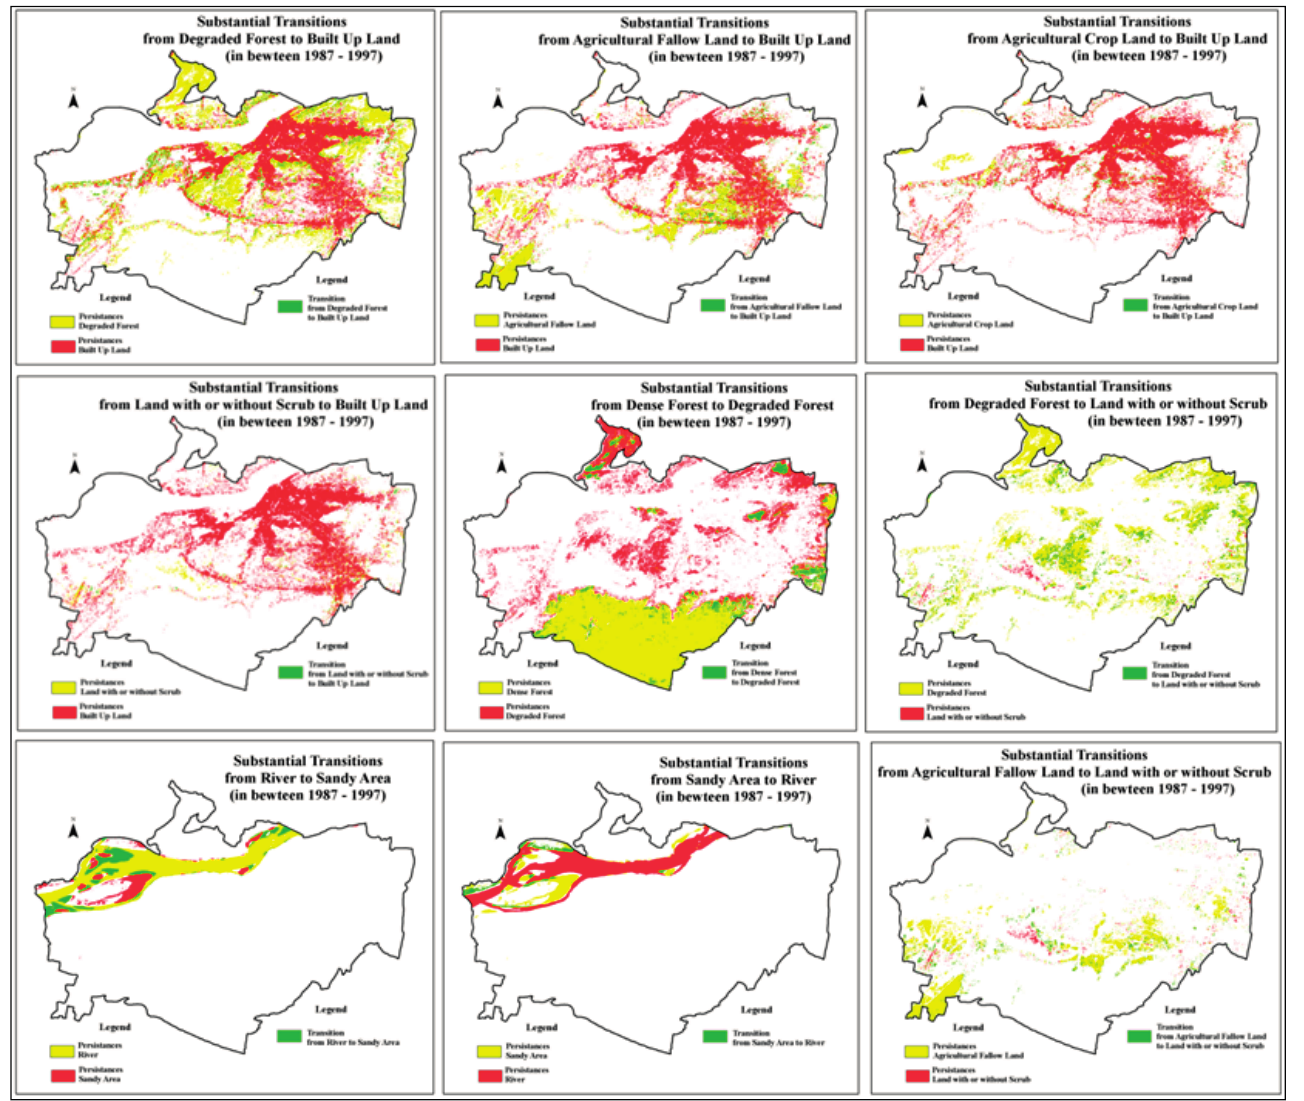
Figure 17. Substantial transitions between different LULC during